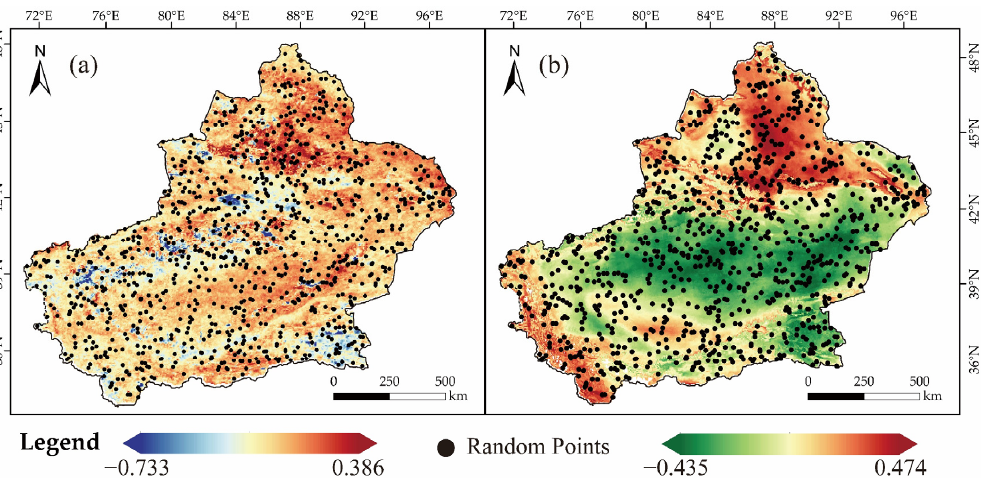
Figure 7. ( a ) The Sen’s slope of surface temperature. ( b ) The Sen’s slope of PET. A Sen’s slope value less than 0 indicates an increasing trend. On the contrary, there is a decreasing trend